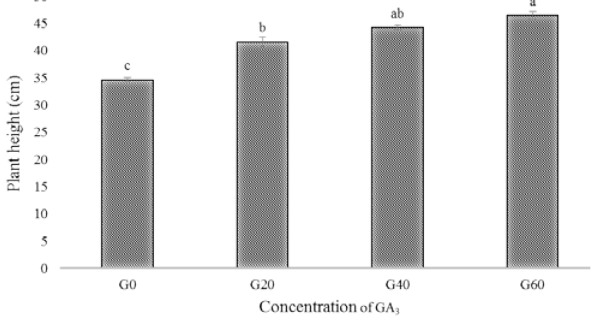
Fig. 1. Effect of various doses of GA on onion plants height at Fig. 2. Effect of various doses of GA 3 harvest. Vertical bars represent means ± standard error mean. onion harvest. Vertical bar represents means ± standard error Means with the same letter did not significantly differ from mean. Means with the same letter did not significantly differ each other at p < 0.05. Abbreviations are as follows, G ; 0, G ; from each other at p < 0.05. Abbreviations are as follows, G0; 0 20 20, G ; 40 and G ; 60 ppm GA respectively 0, G20; 20, G40; 40 and G60; 60 ppm GA3 40 60 3